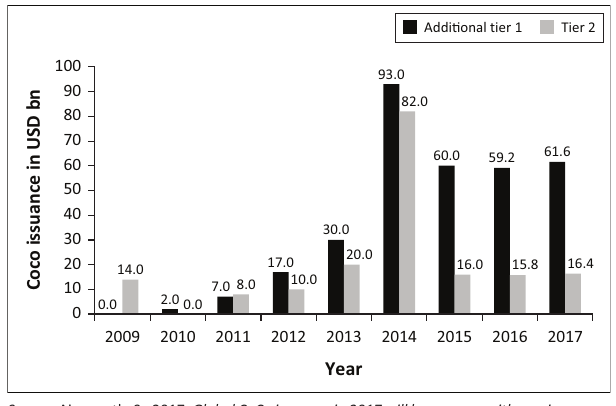
FIGURE 1: Global contingent convertible issuance (in US $ billion).